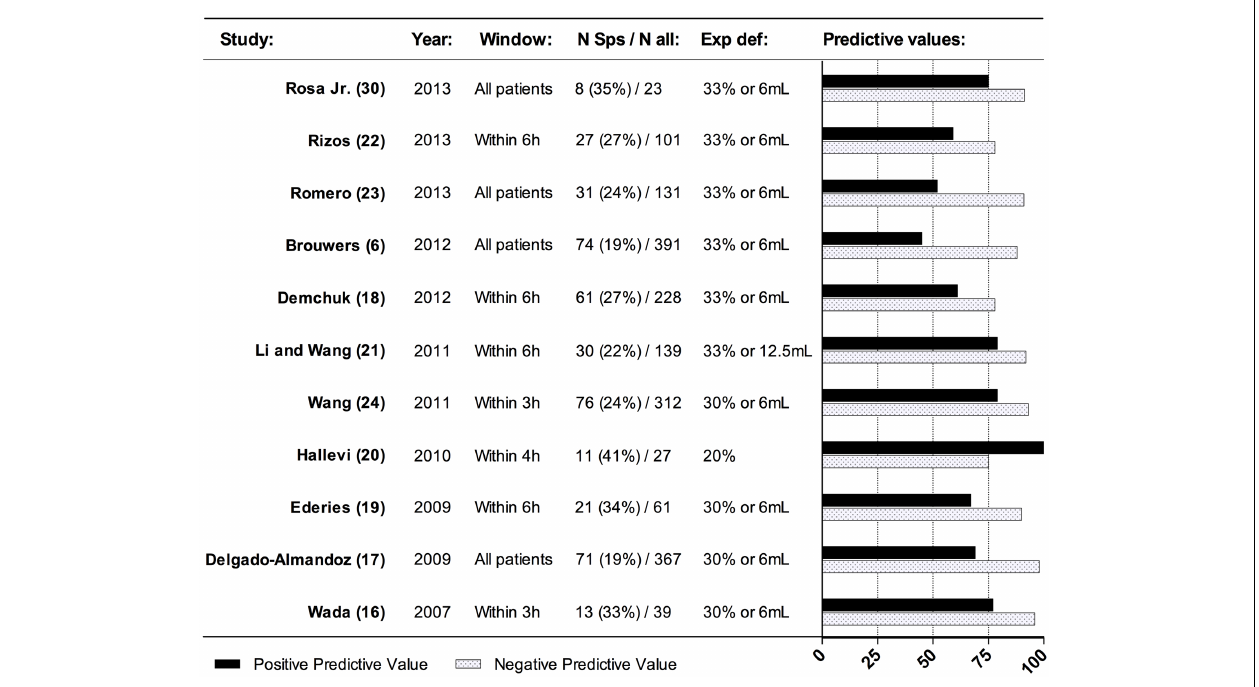
FIGURE 4 | Effect of spot sign on hematoma expansion .This figure presents the predictive values across studies for spot sign in predicting hematoma expansion. N Sps, number of patients with spot sign; N all, total number of patients in the population; exp def, definition of hematoma